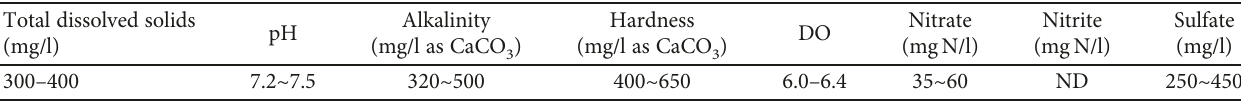
Table 2: Water quality parameters of the groundwater.